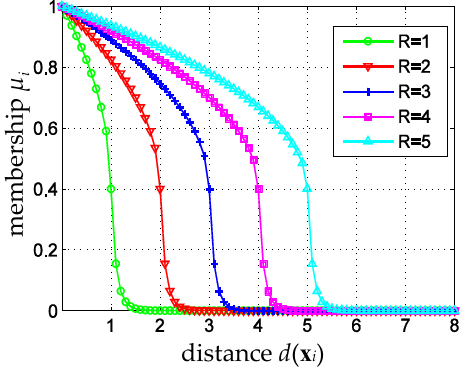
Figure 3. The modified membership function with ρ I = 0.5, ρ o = 10, and ˆ µ = 0.4.